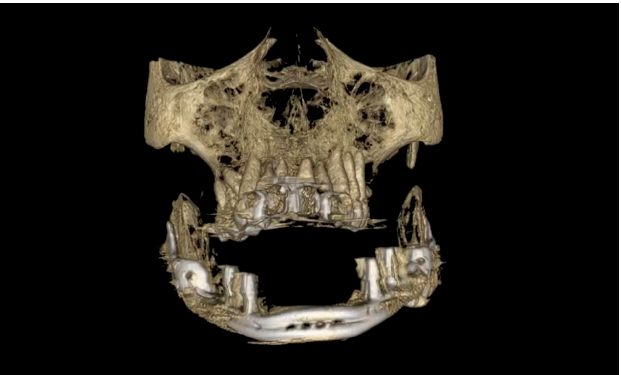
Figure 15. Orthopantomography two months after surgery. Int. J. Environ. Res. Public Health 2020 , 17 , x